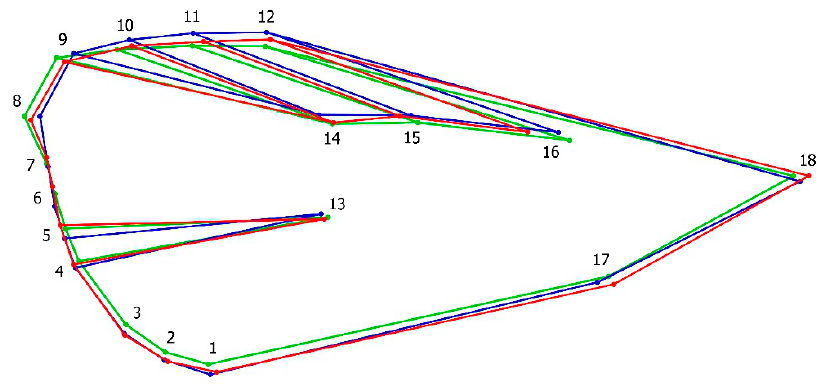
Figure 3. Wireframe visualization of the average shape for different management types of codling moth: ecological (green); laboratory-reared (red); integrated (blue) populations. Table 1. Procrustes ANOVA for both centroid size and shape of codling moth populations.